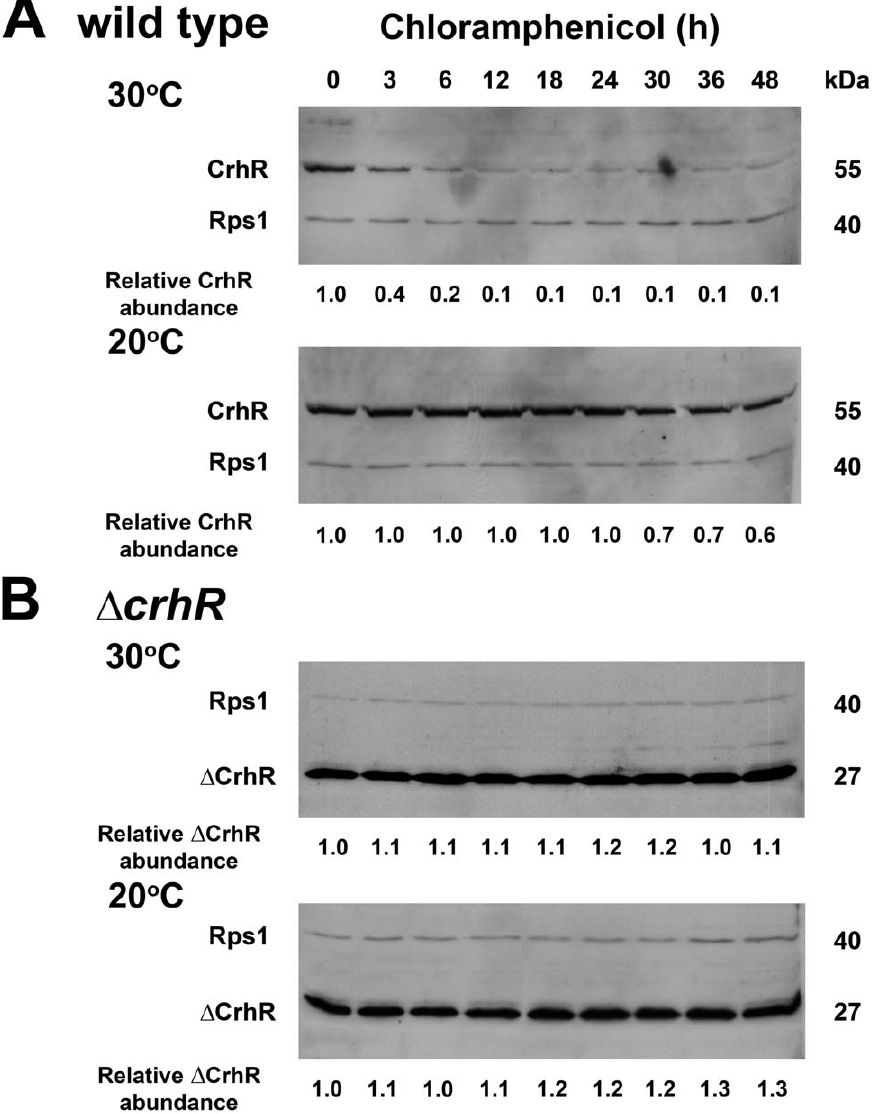
Figure 5. CrhR protein half-life. Wild type ( A ) and D crhR ( B ) Synechocystis were grown to mid-log phase at 30 u C (0 min) at which time the cultures were transferred to 20 u C for 2 h to achieve maximum CrhR and D CrhR abundance. Chloramphenicol (250 m g/ml) was added to inhibit de novo protein synthesis and one-half of each culture was transferred back to 30 u C. Samples for soluble protein extraction were harvested at the indicated times. Blots were simultaneously probed with antibodies against CrhR and E. coli ribosomal protein S1 (Rps1), used as a control for protein loading. Quantification of relative CrhR and D CrhR protein abundance at each time point is provided, below each lane, normalized for the level of Rps1, as described in Methods